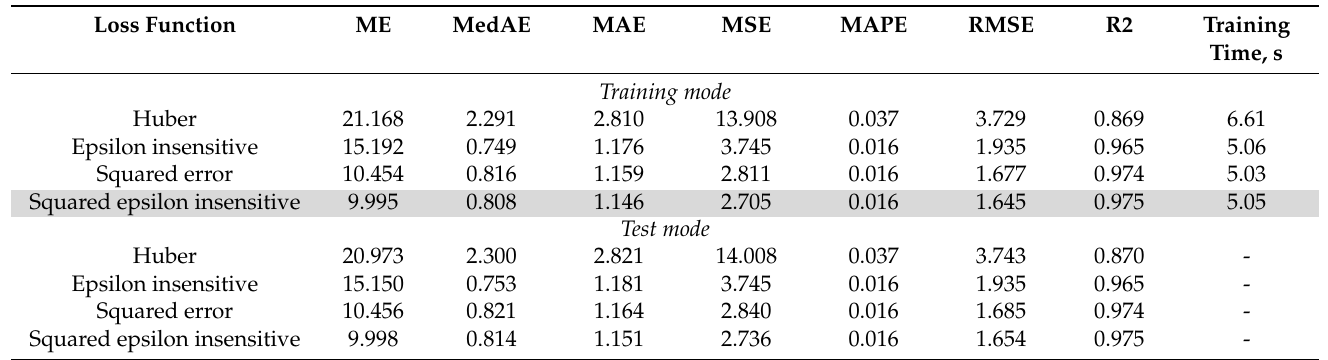
Table 2. Performance indicators for different loss functions.